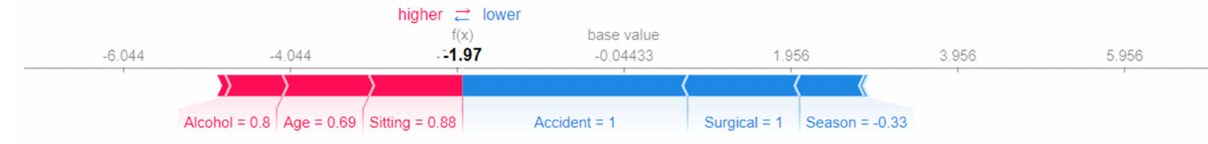
Figure 6. Local visual explanation of the proposed